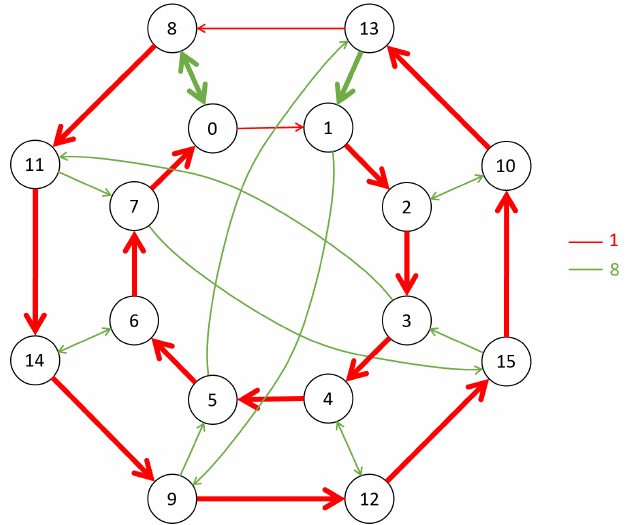
Figure 6. The right-Cayley graph R-Cay ( G ( 4 ) , { 1,8 } ) with the Hamiltonian cycle 0 [ 8 [ 1 ] 7 ] 2 shown in thick